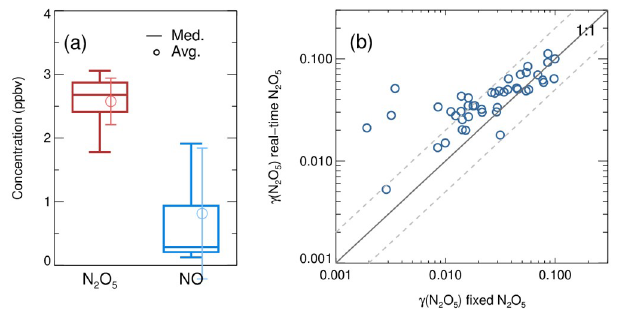
Figure B2. (a) The box whisker of N 2 O 5 source and NO measured before the entrance; (b) the intercomparison of derived N 2 O 5 up- take coefficients by using a fixed initial N 2 O 5 and a dynamic mea- sured N 2 O 5 at the flow tube entrance in the iterative box